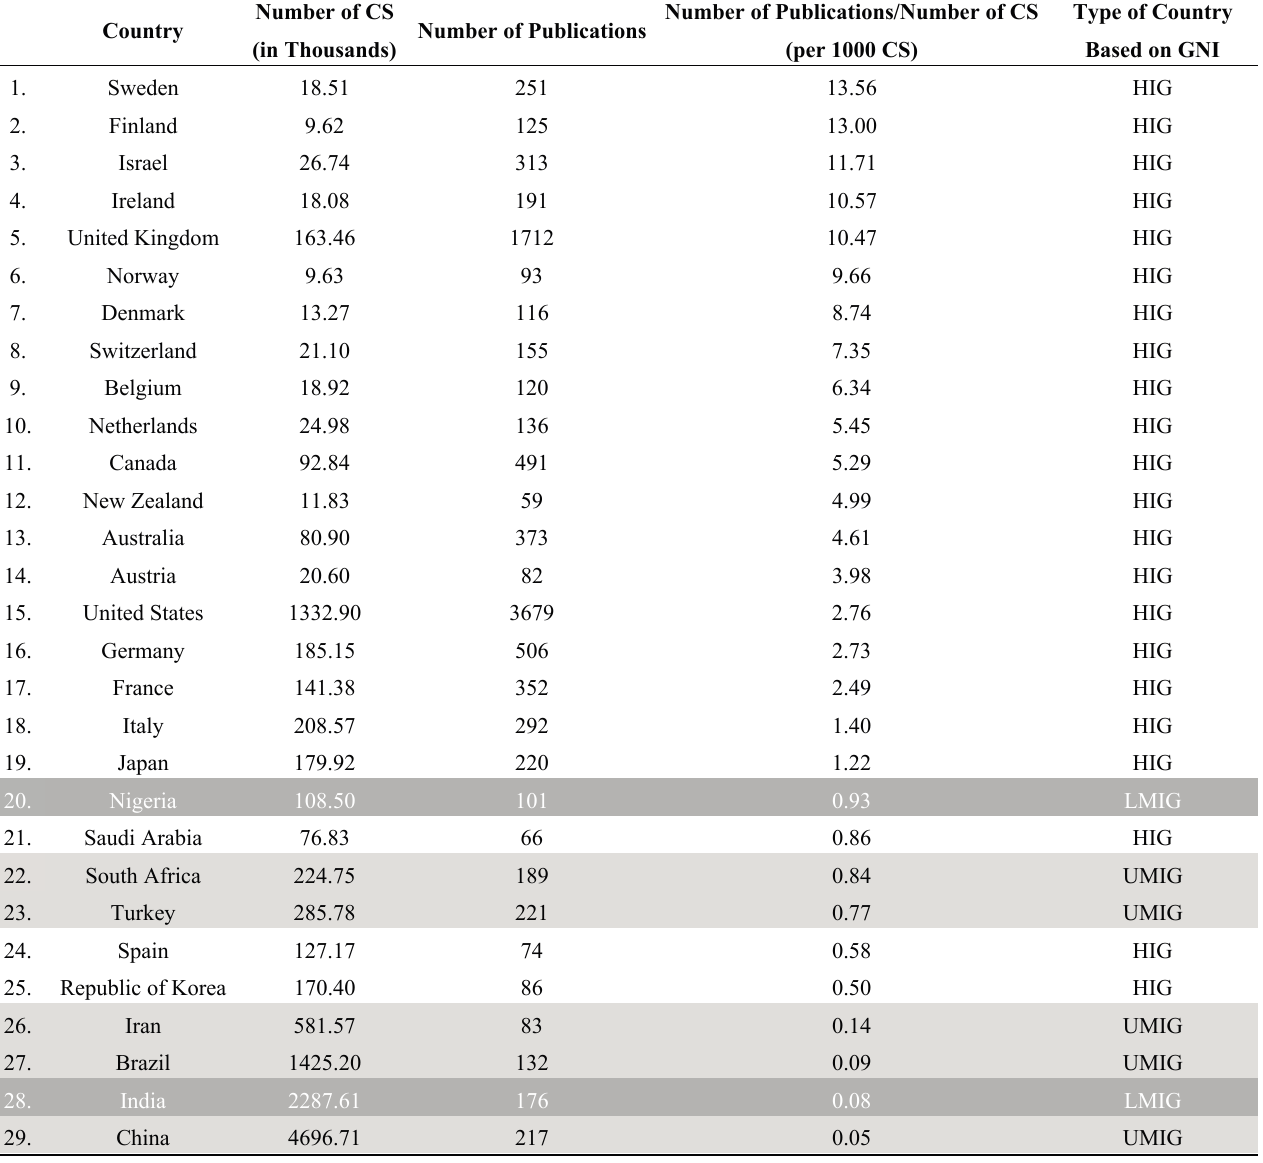
(light grey), LMIG: